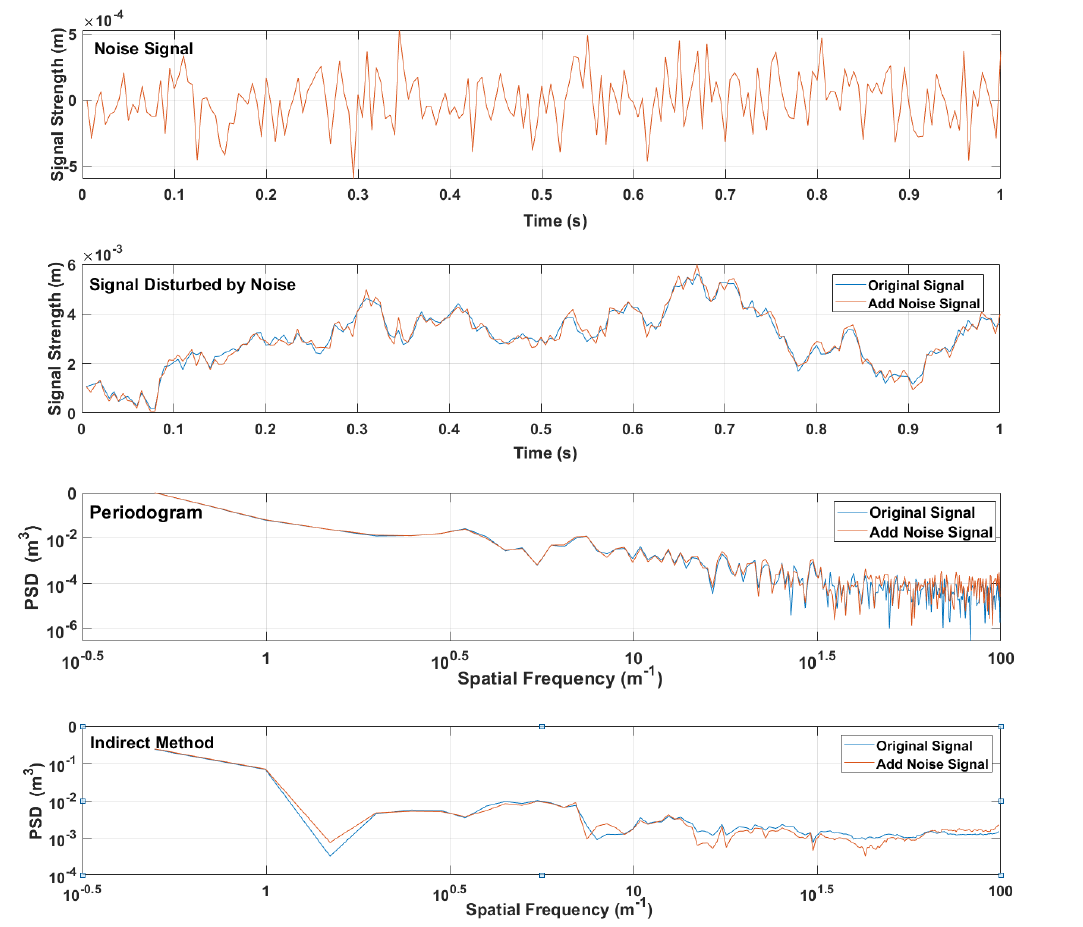
Figure 9. Comparison of noise resistance between periodogram method and correlated power spectrum estimation